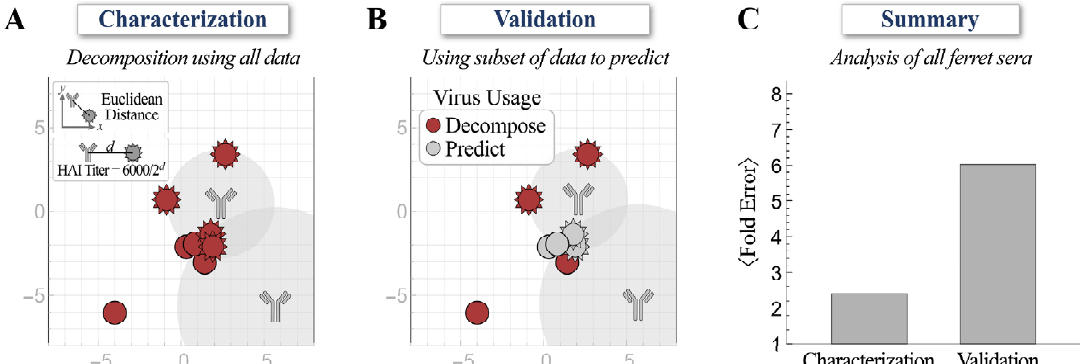
Figure 2. Validating decompositions using a subset of hemagglutination inhibition (HAI) measure- ments. ( A ) The decomposition of ferret antiserum using experimental HAI titers against the full set of viruses. ( B ) Decomposition of ferret antiserum using experimental HAI titers against the half set of viruses (red) to predict the titers of the remaining four viruses (gray). ( C ) The average error from both methods across all ferret antisera analyzed in this work.